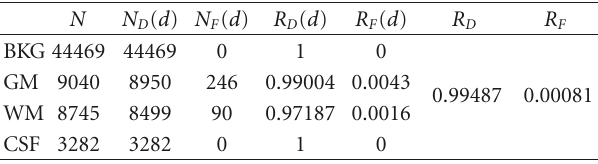
R1/TE1 = 2500 milliseconds/20 milliseconds, TR2/TE2 = 1500 milliseconds/55 milliseconds, TR3/TE3 = 2500 mil- liseconds/75 milliseconds, TR4/TE4 = 2500 milliseconds/100 milliseconds, TR5/TE5 = 500 milliseconds/20 milliseconds.